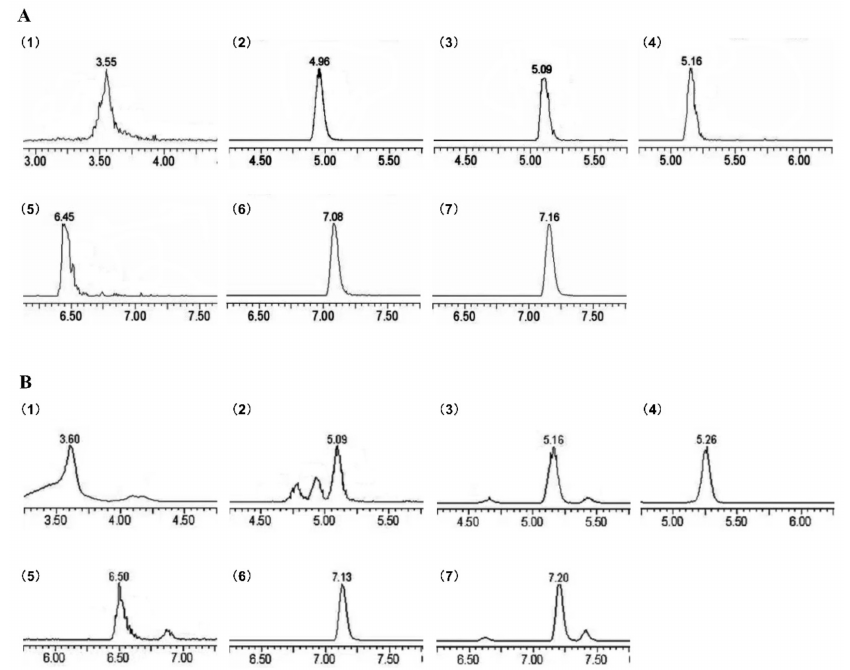
Figure 1. MRM chromatogram of Sonchus arvensis Linn. phenolic compounds (SAP) showing the presence of seven phenolic compounds as identified. ( A ) MRM chromatogram of standards; ( B ) MRM chromatogram of SAP. Peaks: (1) chlorogenic acid, (2) scopoletin, (3) rutin, (4) hyperin, (5) quercetin, (6) apigenin, (7) chrysoeriol.